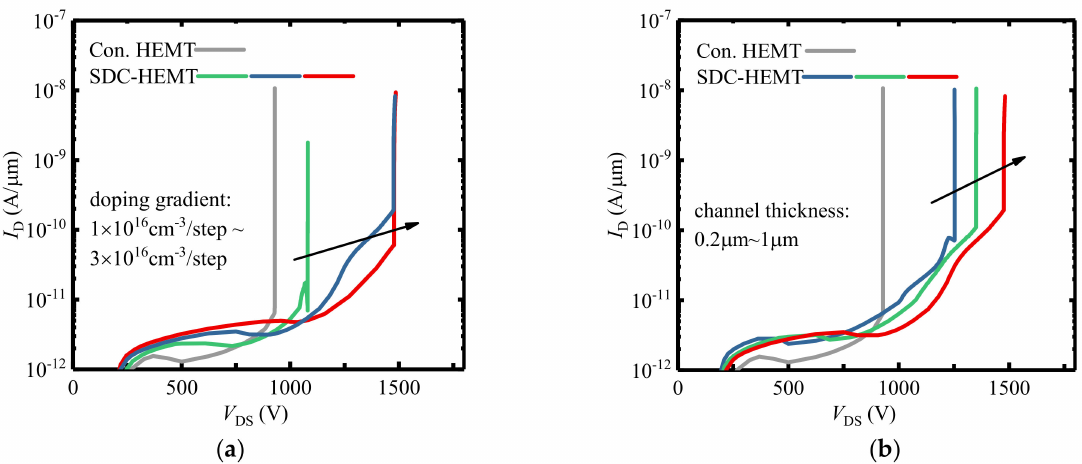
Figure 2. The off–sate I d – V d characteristics of the conventional HEMT and the SDC–HEMTs with ( a ) various doping gradients (the channel thicknesses of SDC–HEMTs are 1 µ m) and ( b ) various channel thicknesses (the doping gradients of the SDC–HEMTs are 2 × 10 16 cm − 3 /step). The channel thickness of the conventional HEMT is 1 µ